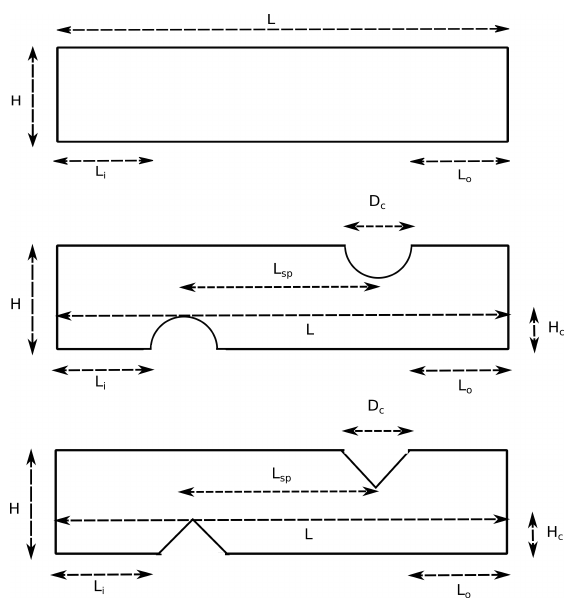
Figure 2. Schematic presentation for sections of the geometry of flat, cylindrical, and triangular corrugated channels with characteristic length